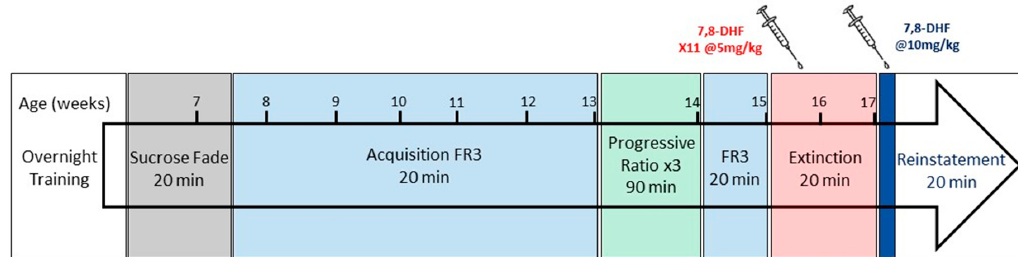
Figure 1. Experimental timeline of treatment protocol depicting the stages of operant training and response. Rats were trained in 1 overnight session followed by a sucrose fade, and lever presses were recorded during acquisition, progressive ratio, extinction, and reinstatement. FR = Fixed Ratio.